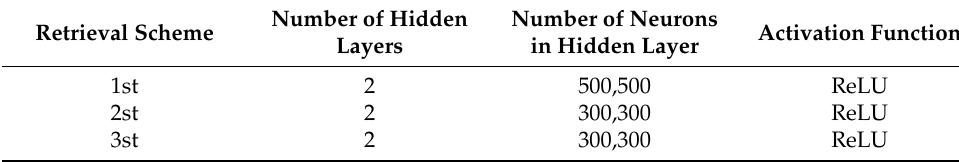
Table 3. The SNN configuration. Retrieval